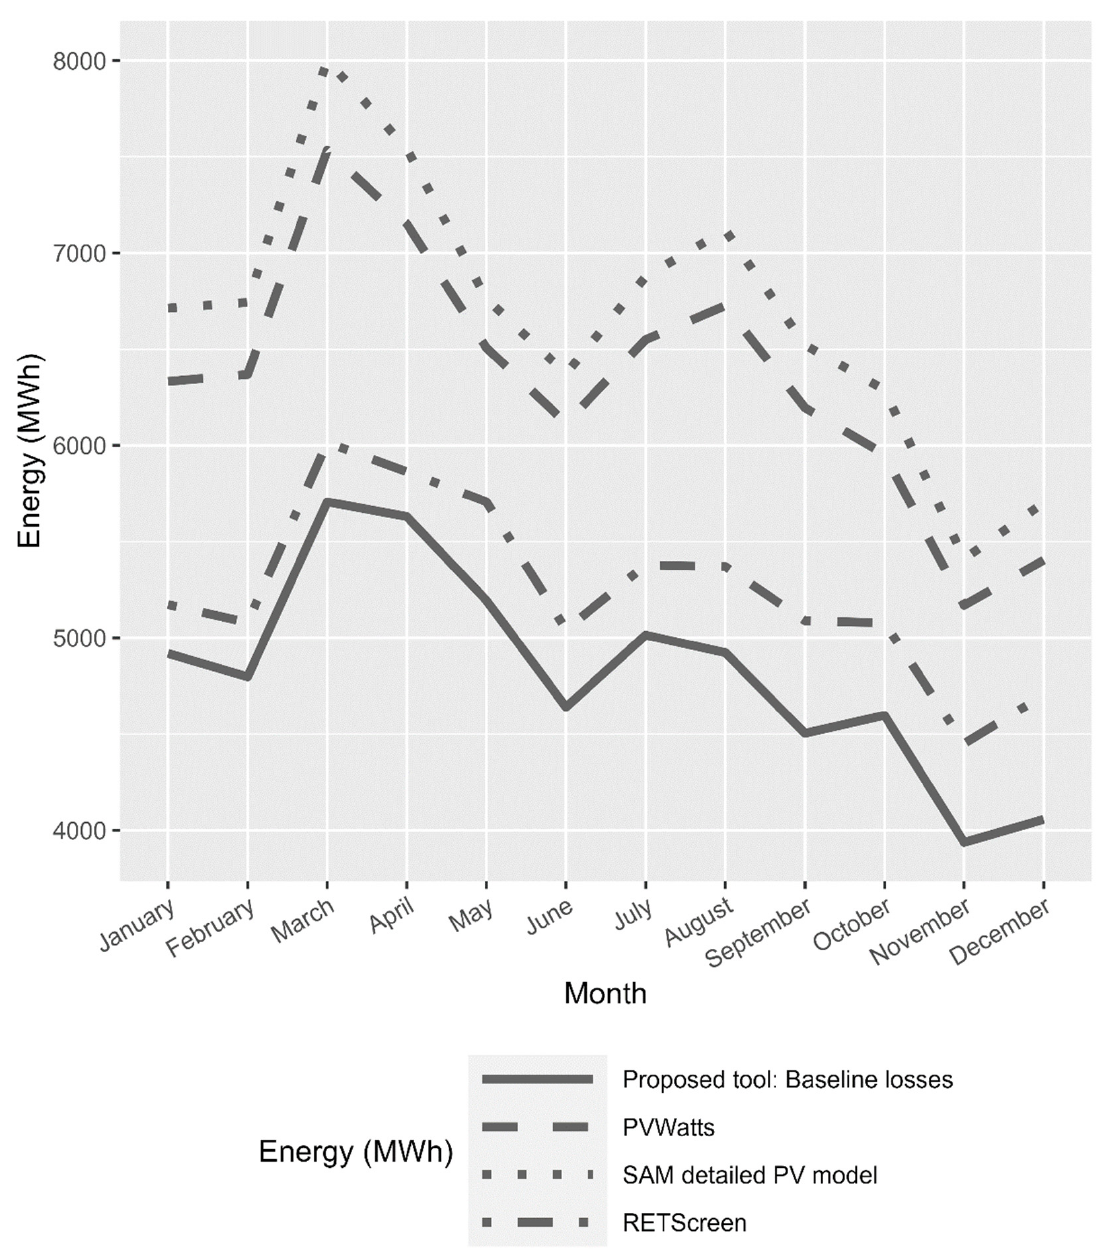
Figure 6. Monthly energy output estimations using the baseline loss model of the proposed prefea- sibility tool, PVWatts, SAM’s detailed photovoltaic model and